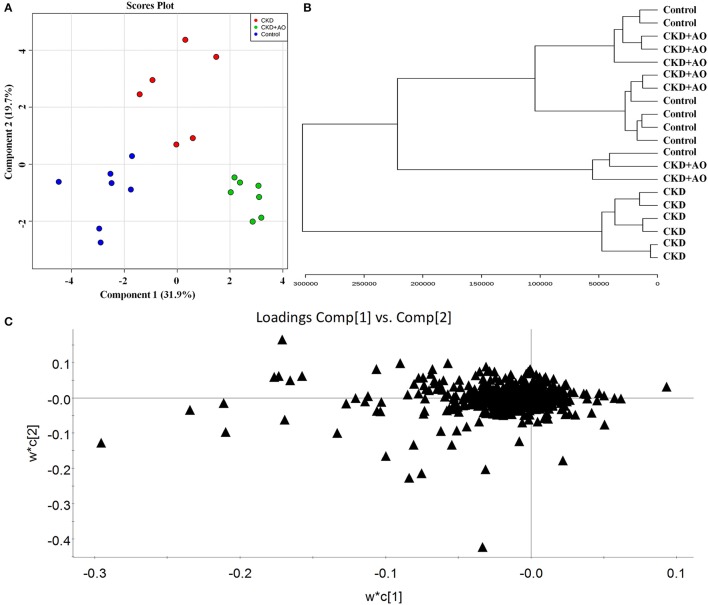
Lipid profiling and multivariate statistical analysis. (A) PLS-DA model for control, adenine-induced CKD and CKD+AO groups. (B) Clustering analysis of control, adenine-induced CKD, and CKD+AO groups. (C) Loadings plot of PLS-DA in positive and negative ion mode from control, adenine-induced CKD, and CKD+AO groups.